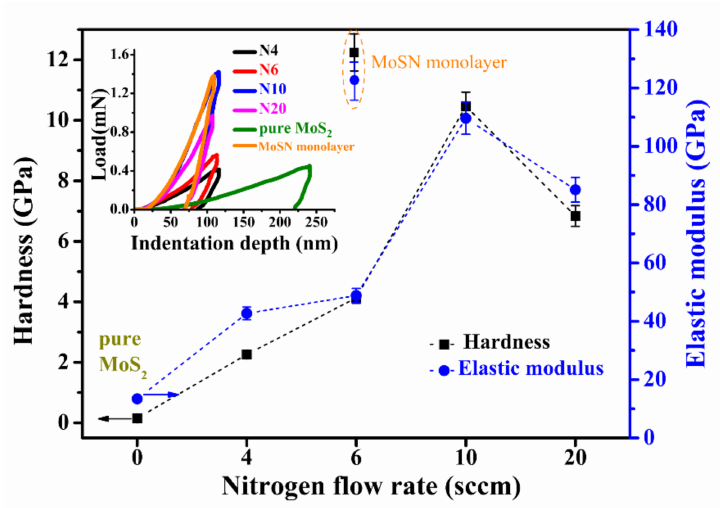
Figure 4. Hardness and elastic modulus of pure MoS 2 film, MoSN monolayer and MoSN/MoS 2 multilayer films with different nitrogen flow rates. The corresponding load-displacement curves are